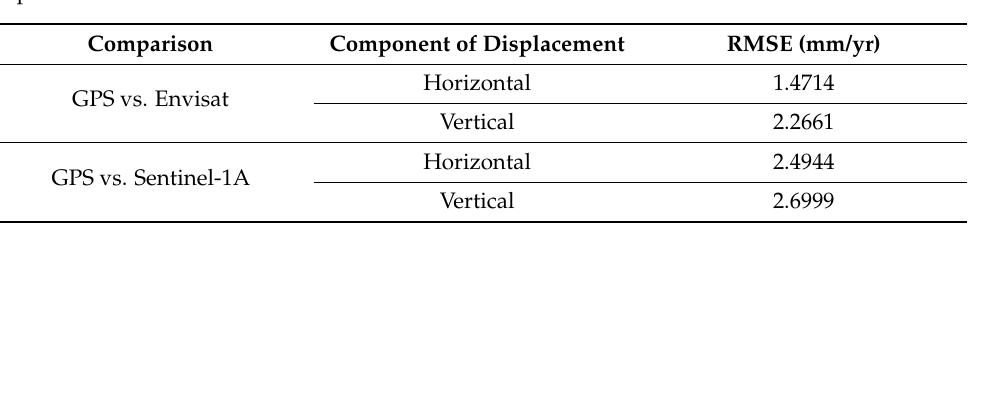
Table 3. RMSE calculated for each comparison made between GPS and SAR horizontal and vertical displacement rates.